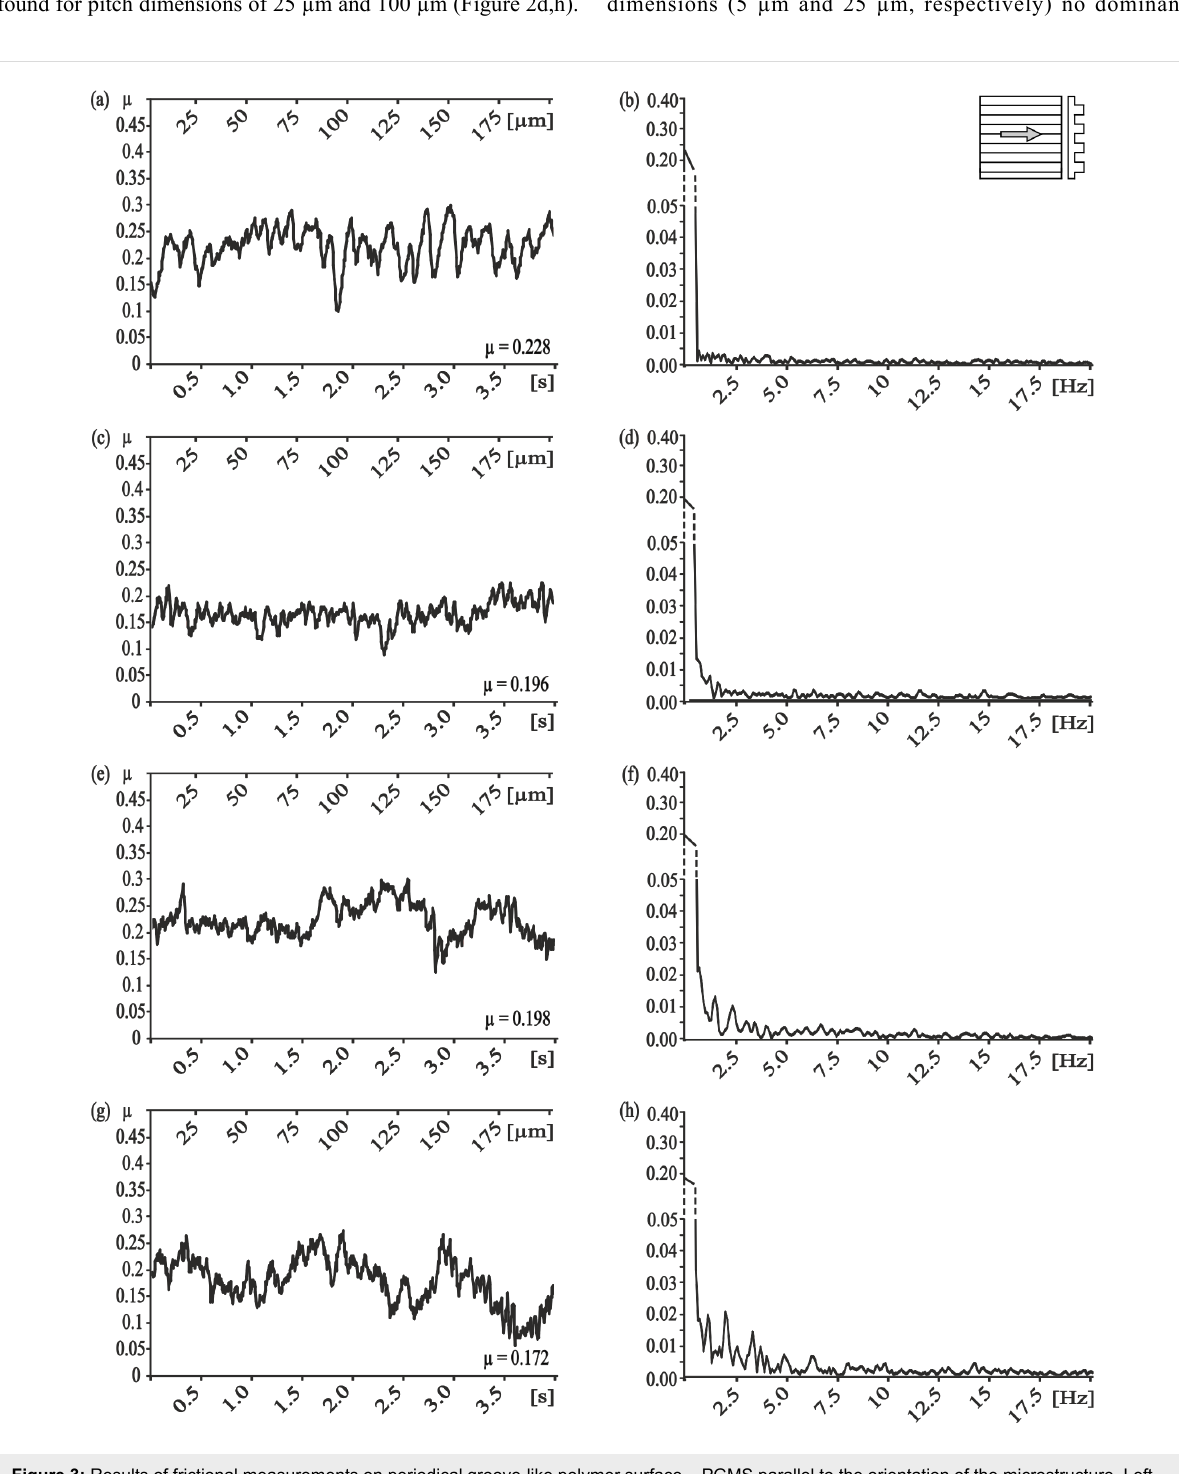
Figure 3: Results of frictional measurements on periodical groove-like polymer surface – PGMS parallel to the orientation of the microstructure. Left column, frictional signal in the spatial/time domain. Right column, frictional signal in the frequency domain after FFT; the ordinate shows the single- sided amplitude spectrum – SSAS. PGMS pitch dimension: a,b) 5 µm, c,d) 25 µm, e,f) 50 µm, g,h) 100